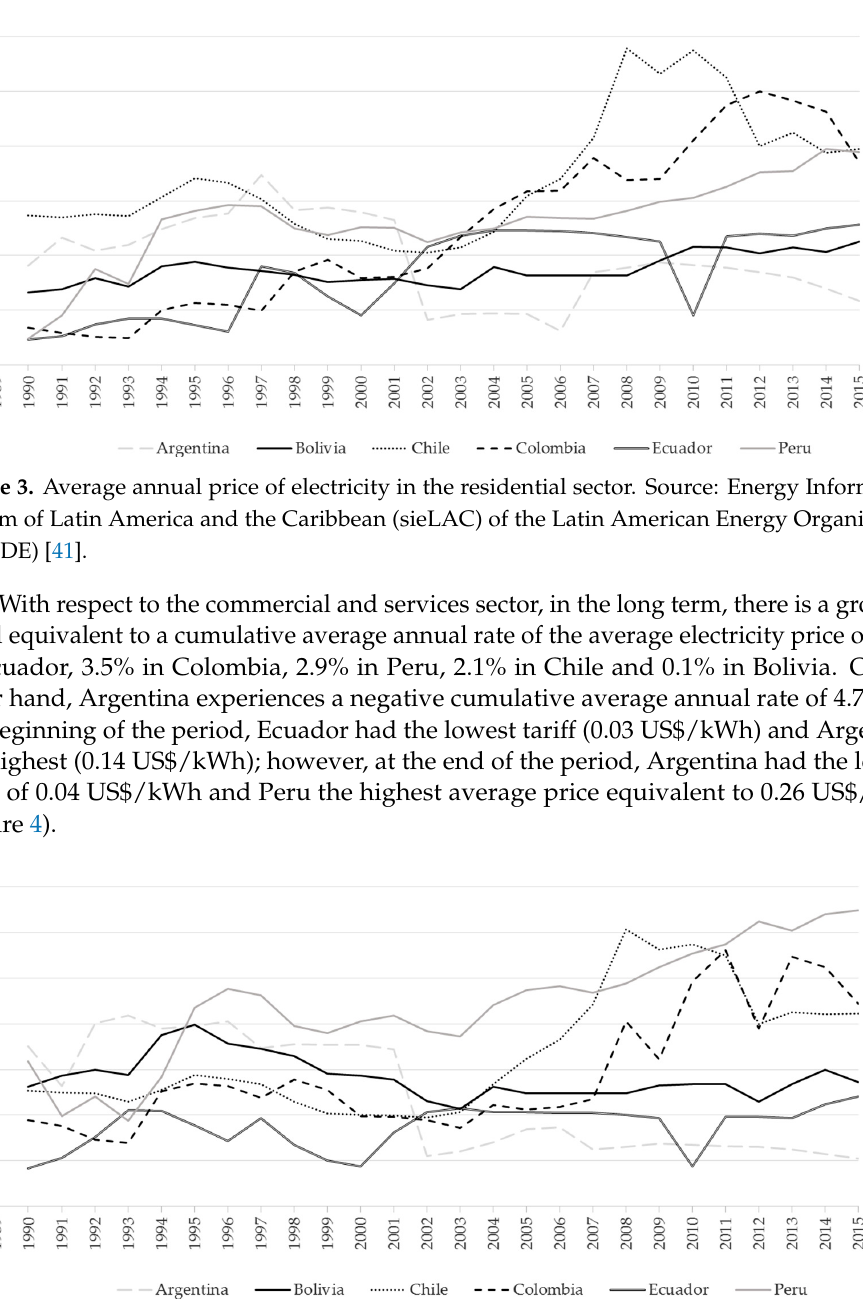
Figure 2. Annual average price of electricity in the industrial sector Source: Energy Information System of Latin America and the Caribbean (sieLAC) of the Latin American Energy Organization (OLADE) [41].